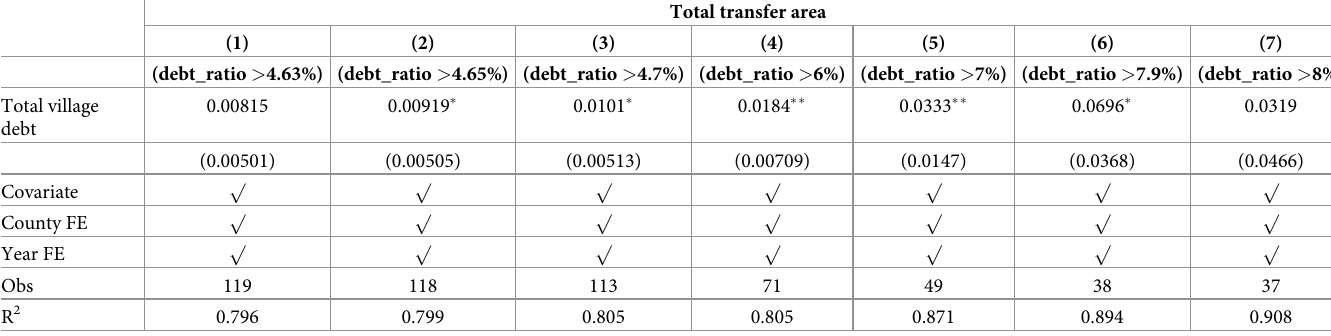
Table 4. The estimation results of village-level debt and rural land transfer in different debt_tatio.